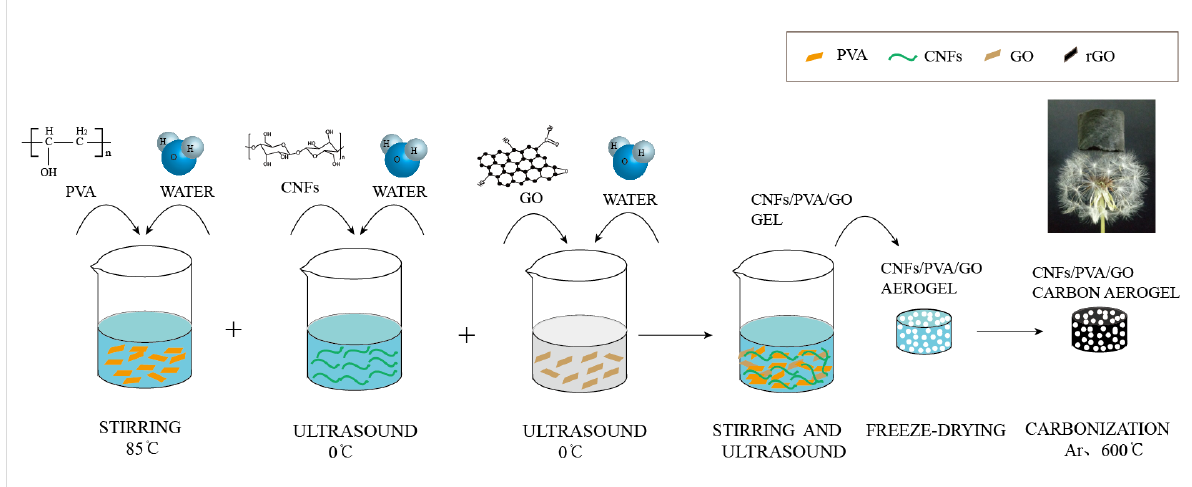
Figure 12: Schematic showing the synthetic steps for preparing super-hydrophobic CNF/PVA/GO carbon aerogel.